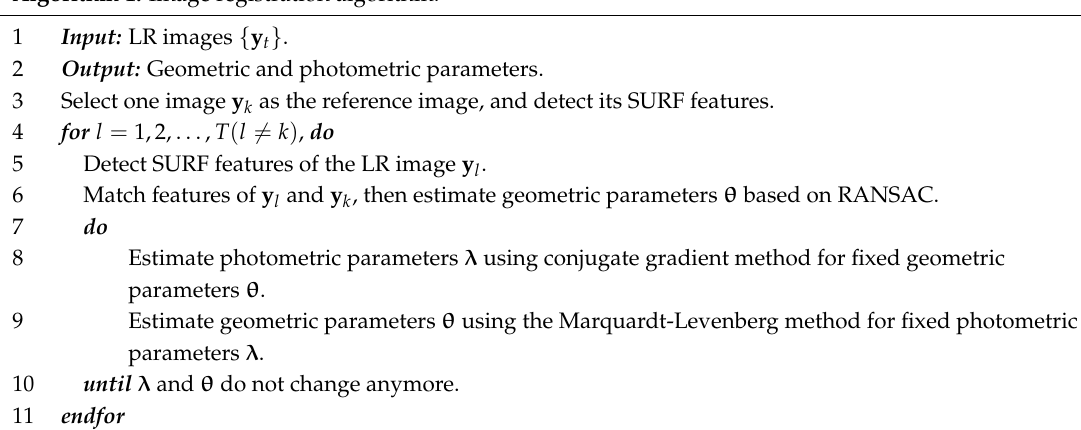
Algorithm 1. Image registration